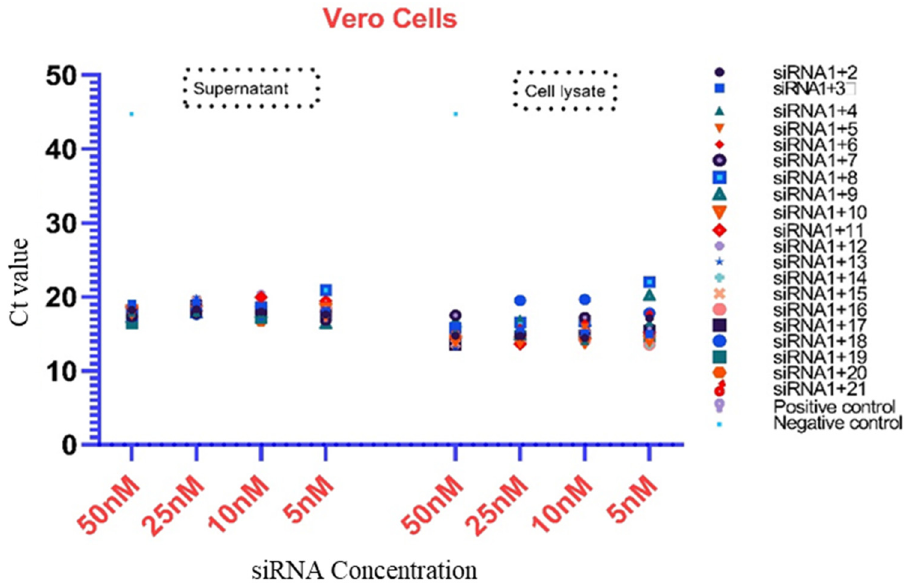
Figure 3. Presentation of the Ct values of the combined use of siRNAs in both the cell lysate and supernatant of Vero cells. Some siRNAs showed better potential as compared to other combinations (50, 25, 10, and 5 nM). The highest Ct value was 45, which occurred in the negative control sample. Table 4. Ct value of qPCR results of siRNA in HEK-293-T